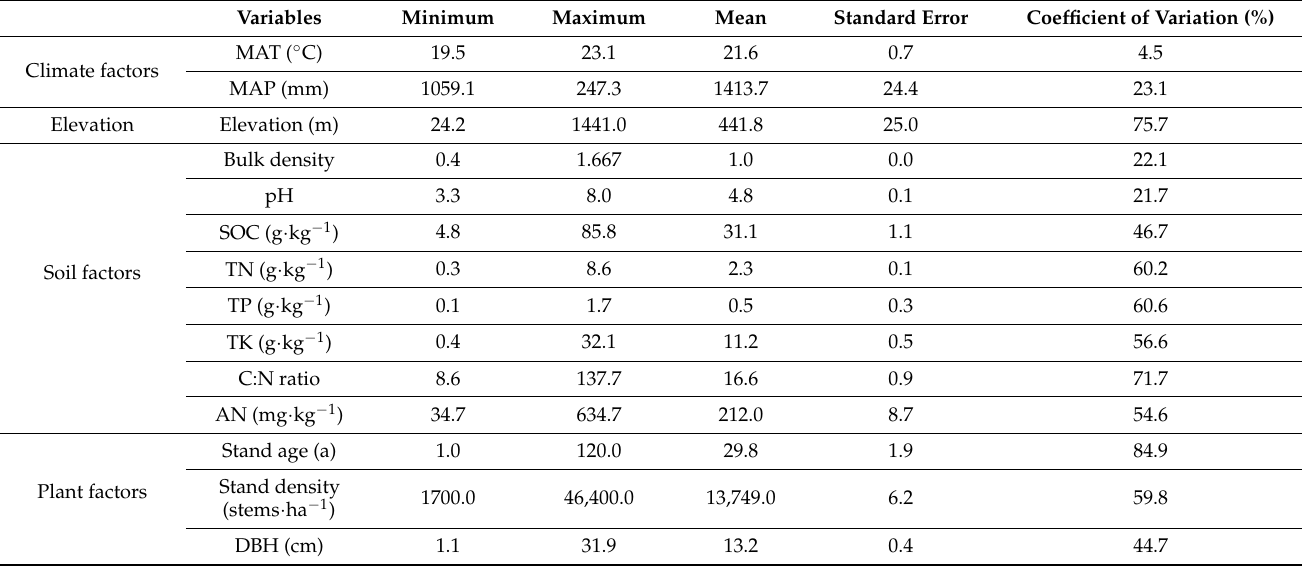
Table 1. Minima, maxima, means, and coefficient variation (CV) of environmental variables in the forests across Guangxi, China ( n =